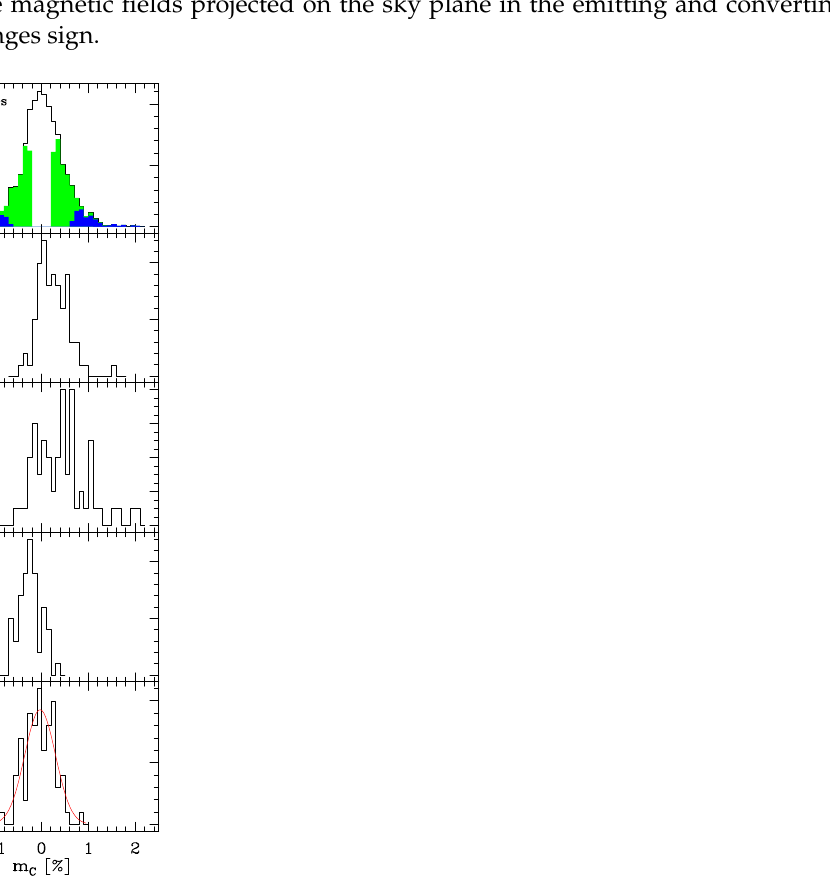
Figure 3. Distribution of 3mm measurements of circular polarization, m C , of a few selected sources, the calibrators and of all data in our sample (2261 valid observations). In the top frame, blue and green colors code measurements with signal-to-noise ratios greater than 3 and 1, respectively. The red curve is a Gaussian fit to the calibrator